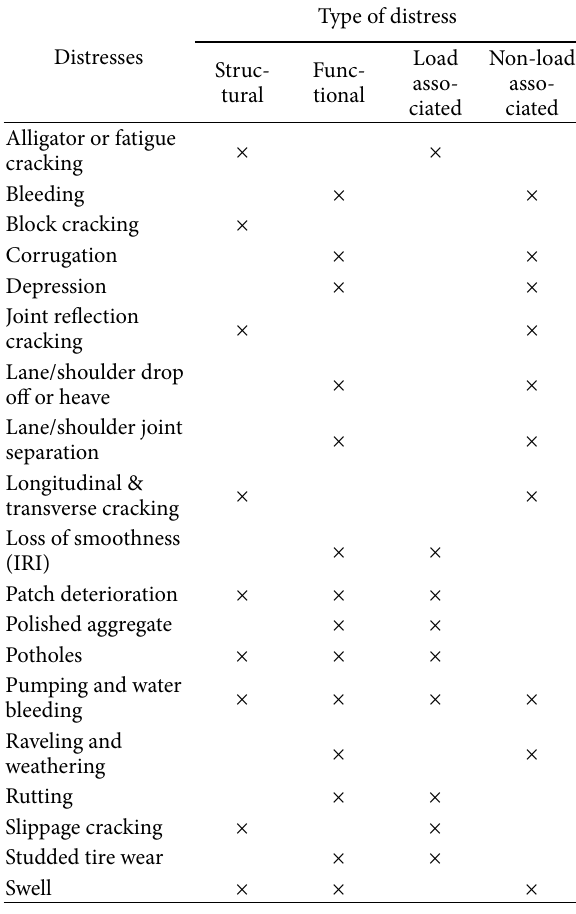
Table 1. Typical asphalt pavement distresses (Huang